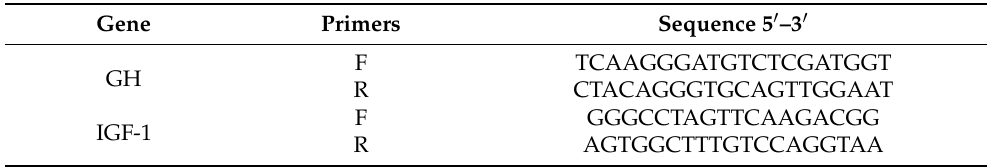
Table 2. Primers used in this